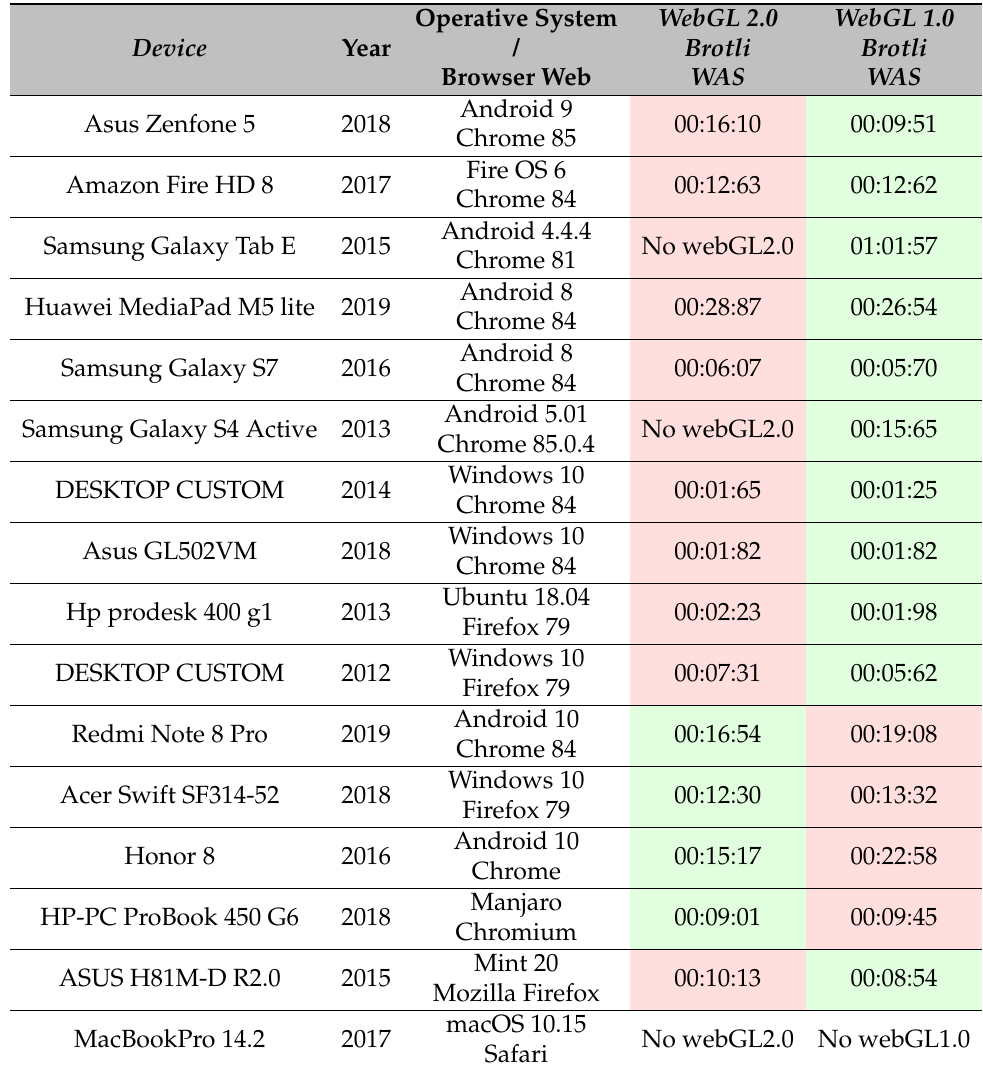
Table 3. Synthetic comparison of the results.